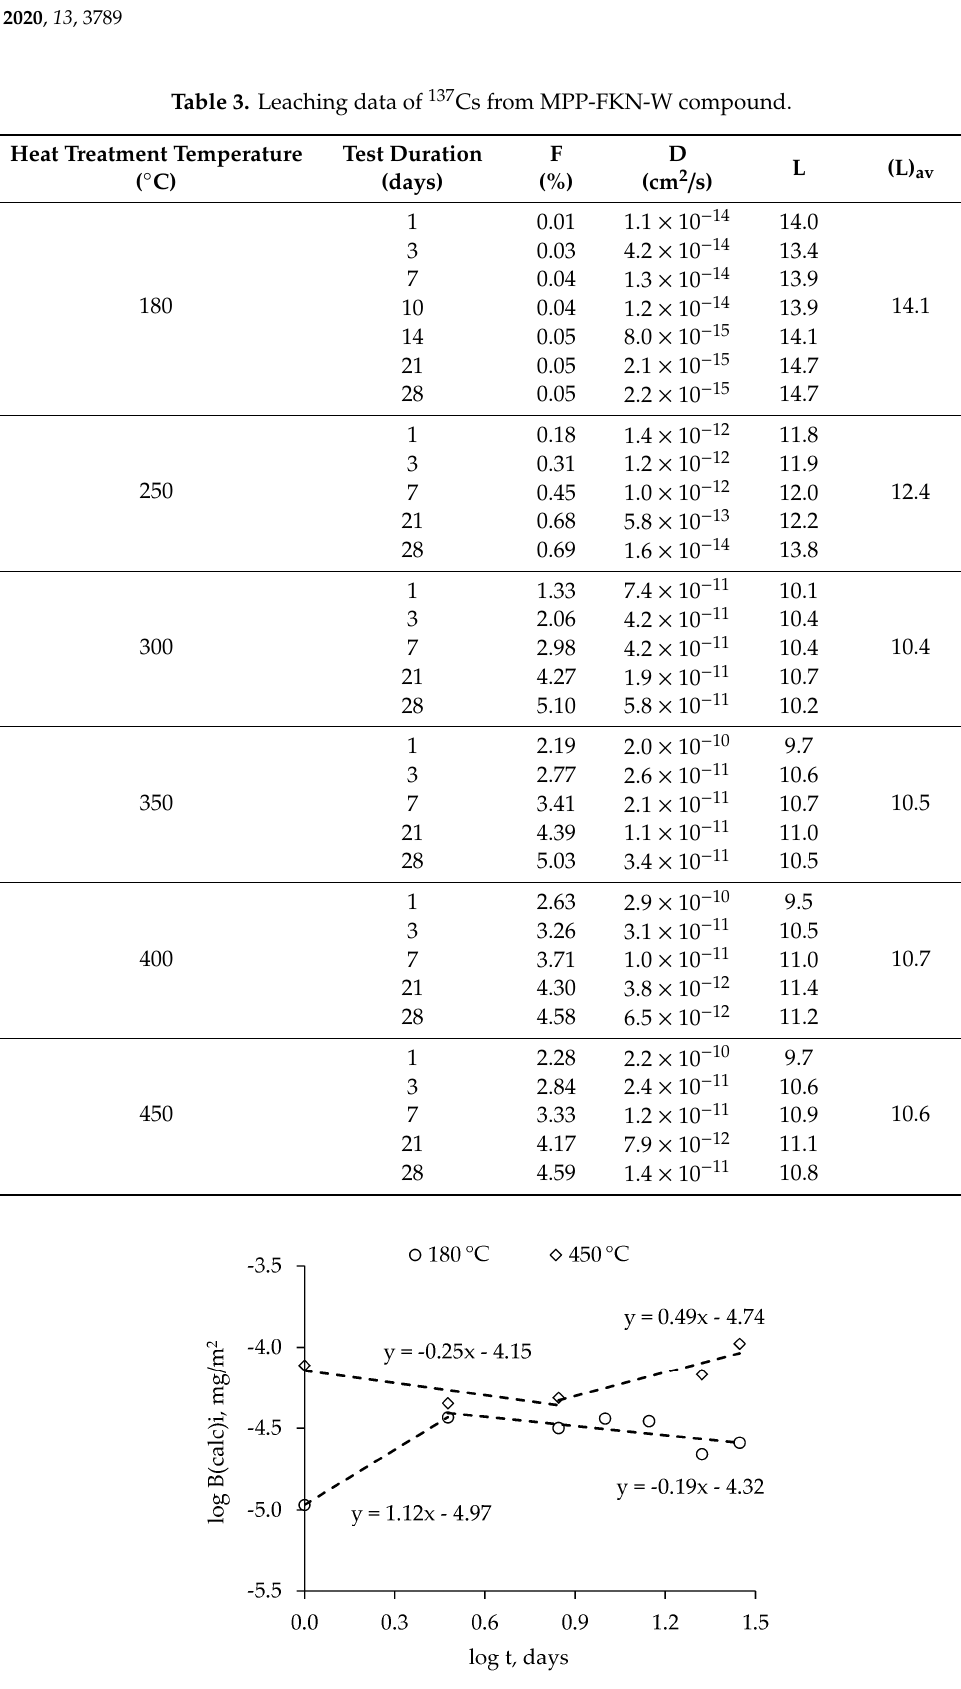
Table 3. Leaching data of 137 Cs from MPP-FKN-W compound.